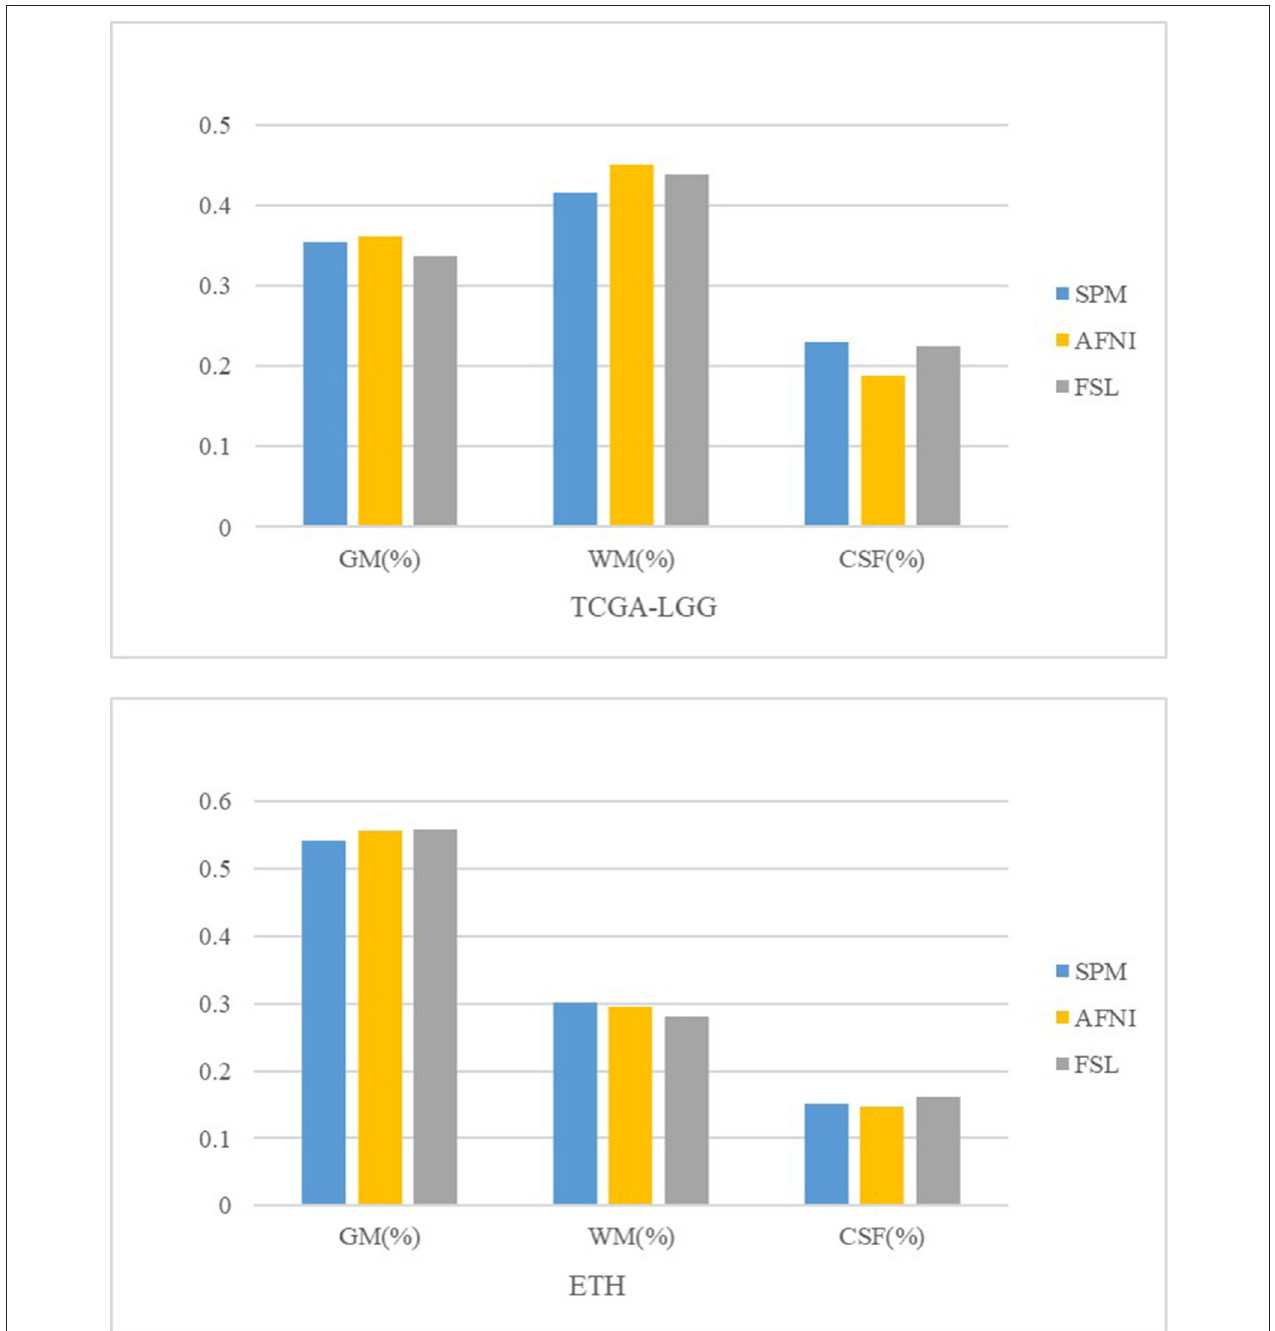
FIGURE 4 | Brain tissue volume